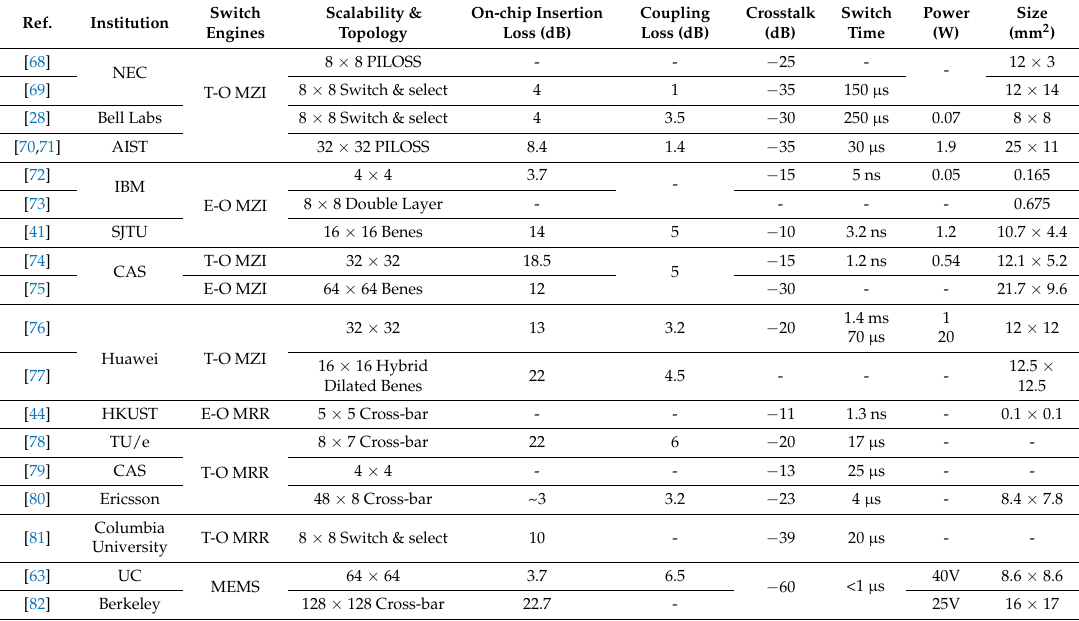
Table 1. Comparison table of large-scale optical waveguide switch fabrics.